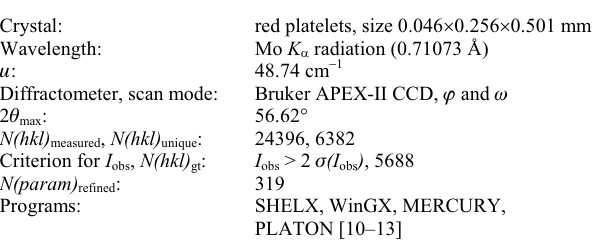
Table 1. Data collection and